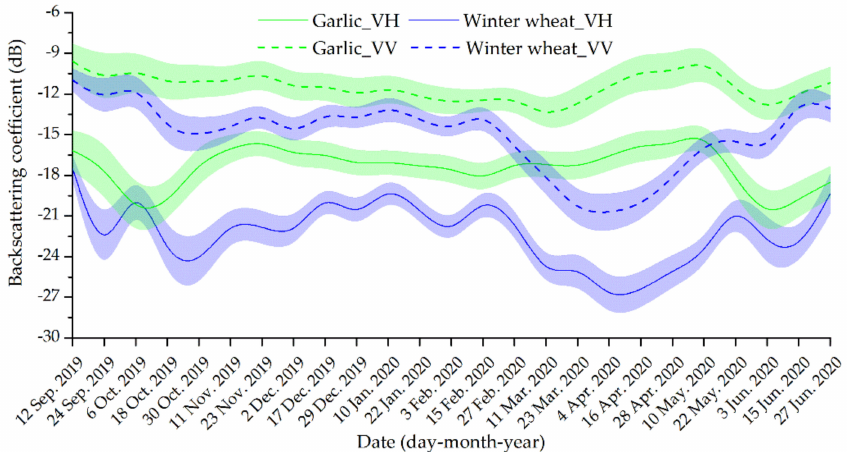
Figure 4. Time series of Sentinel-1 curves for garlic and winter wheat. Green and blue refer to garlic and winter wheat, respectively. The dotted and solid lines represent the means of the backscattering coe ffi cients of vertical- vertical (VV) and vertical-horizontal (VH) polarization images, respectively. The background color represents the standard